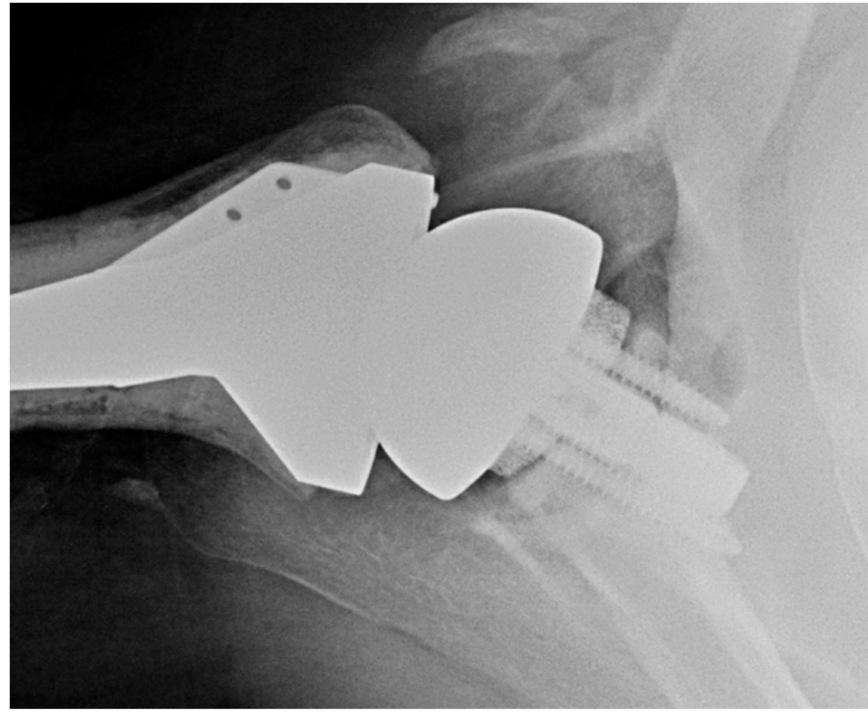
Figure 6. RSA with augmented baseplate. Axillary X-ray of augmented glenoid baseplate.